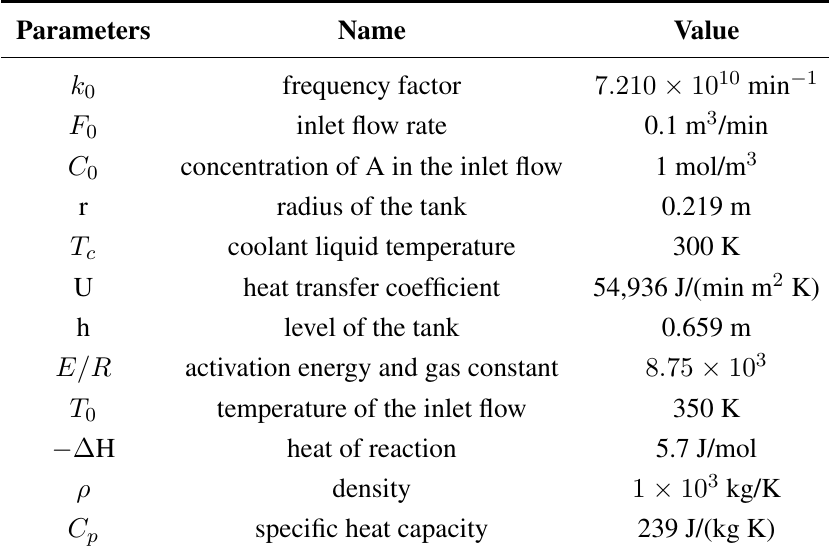
Table 1. Parameters of the